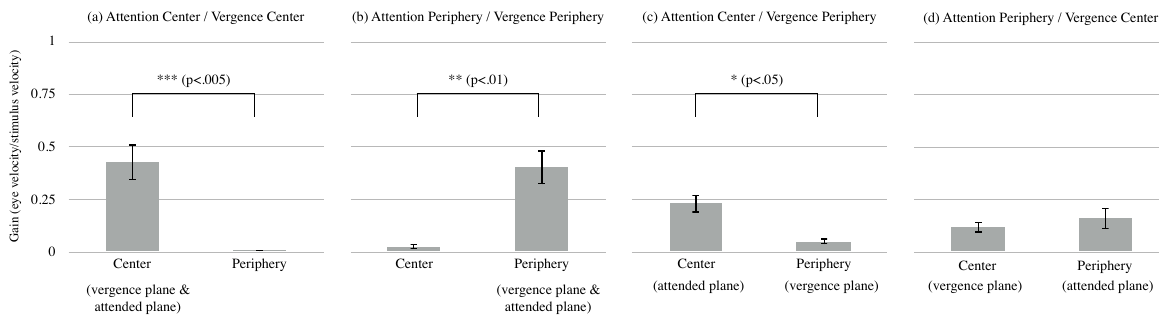
Figure 6. Mean frequency of OKN in the experiment for each condition of directed vergence and attention: The horizontal axis presents the position of stimulus motion to which OKN corresponded, and the parentheses under that indicate instruction for observers. The vertical axis presents the frequency of OKN corresponding to the motion of each area. Error bars show ± 1 SEM.